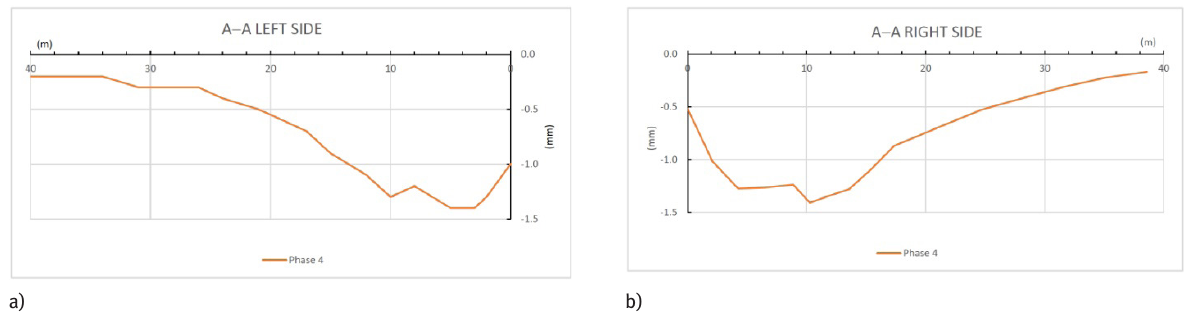
Figure 7: Phase 4 of the implementation – conducting foundation excavation and supporting it with straining beams; graph of vertical displacements of the land surface in the A–A cross section: a) on the left, b) on the right.